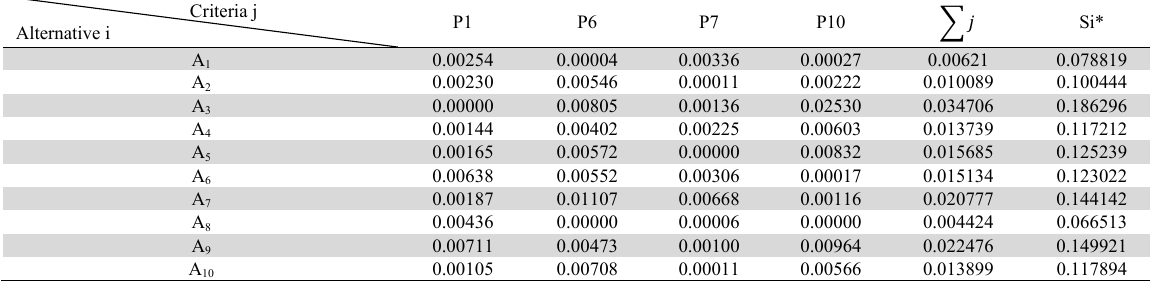
Ideal solution separation measurements